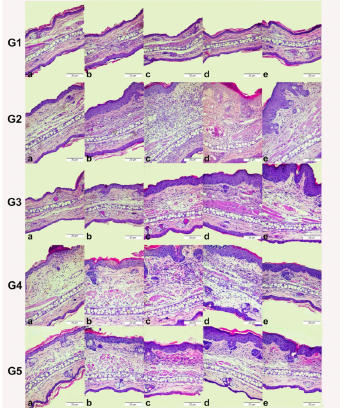
Figure 10. Effect of TAC, non-loaded, and TAC-loaded nanocapsules (NC-N and NC-1) on TPA- induced ear of male Balb/c mice. ( G1 ) Basal group, ( G2 ) inflammatory control group, ( G3 ) NC-N group, ( G4 ) TAC group, ( G5 ) NC-1 group. ( a ) day 2, ( b ) day 4, ( c ) day 6, ( d ) day 8, and ( e ) day 10 of treatment. Images are representative of transverse sections of mice ears stained with hematoxylin and eosin (magnification: 200 × ; scale bar: 20 µ